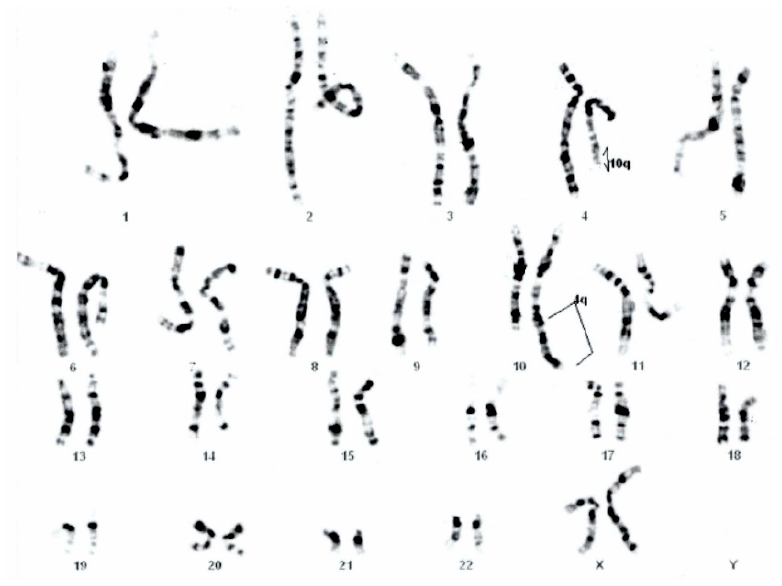
Figure 3. Mother’s karyotype 46,XX,t(4; 10)(q26; q26.2).